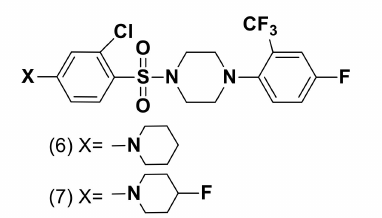
Figure 4. 11 β -HSD1 inhibitors.